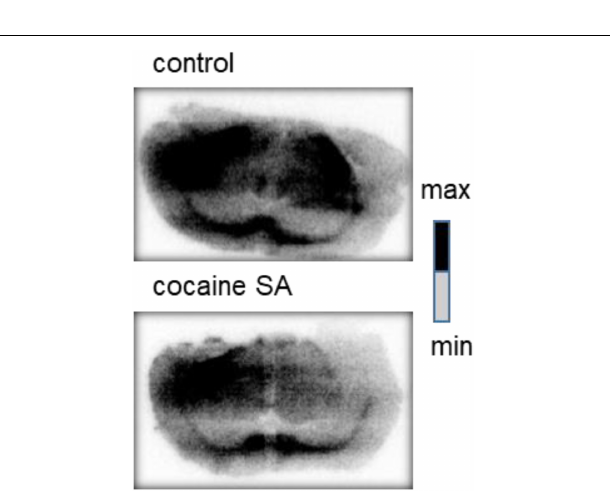
FIGURE 5 | Representative in vitro autoradiography images of a control and cocaine SA rat coronal brain sections with [ 11 C]MPC-6827. We used George paxnos and charles watson in stereotaxic coordinates for the brain coronal sections, with the visible brain structures in the images are the corpus callosum and